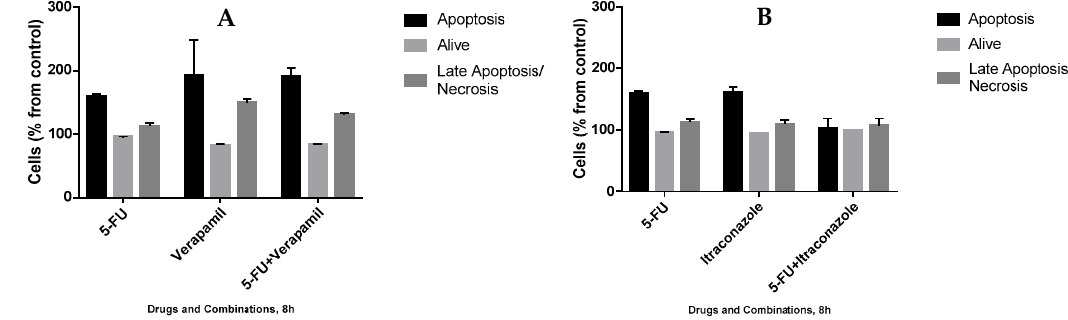
Figure 13. Effect of 5-FU, verapamil ( A ), itraconazole ( B ), and respective combinations of the last two drugs with 5-FU on the death of MCF-7 cells, for 8 h. Each drug and drug combination were added in fresh medium, in duplicates. Results are presented as mean ± standard deviation (SD) of a single experiment.